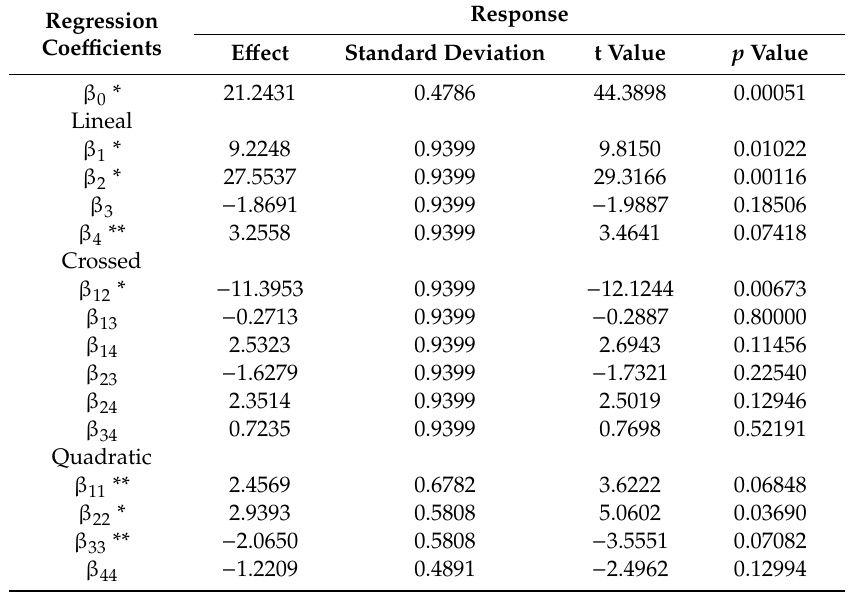
Table 4. Estimated regression coe ffi cients of the adjusted second-order polynomial equation of sulfuric acid model.